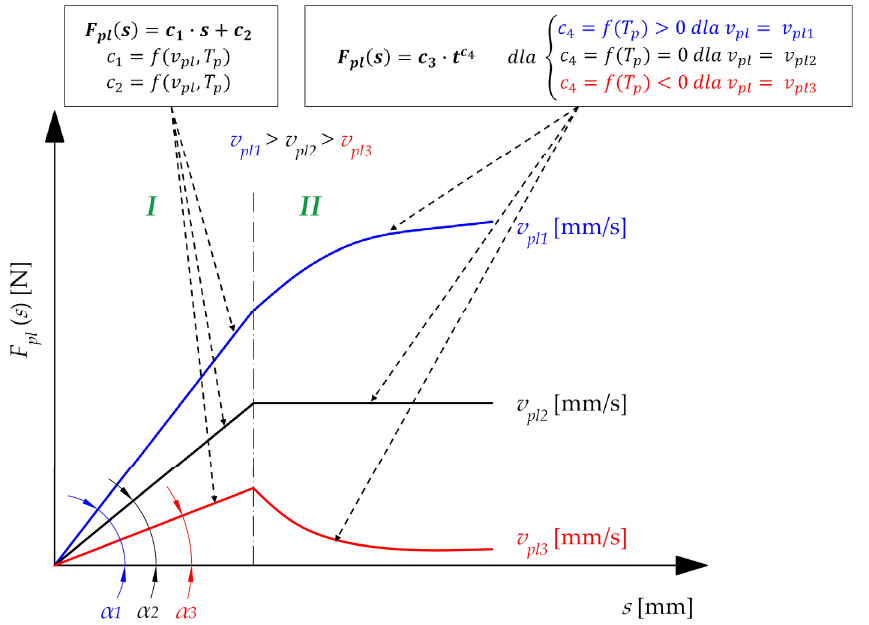
Figure 15. The analysis of the plasticization operation on the hot plate: I —steady-state plasticization, II —non-steady plasticization; F pl —plasticization force, T p —hot plate temperature, s —displacement, v pl 1 … v pl 3 —plasticization velocity, c 1 … c 4 —constant factors, α i —angle of inclination of the propor- tional section of plasticization correlation.